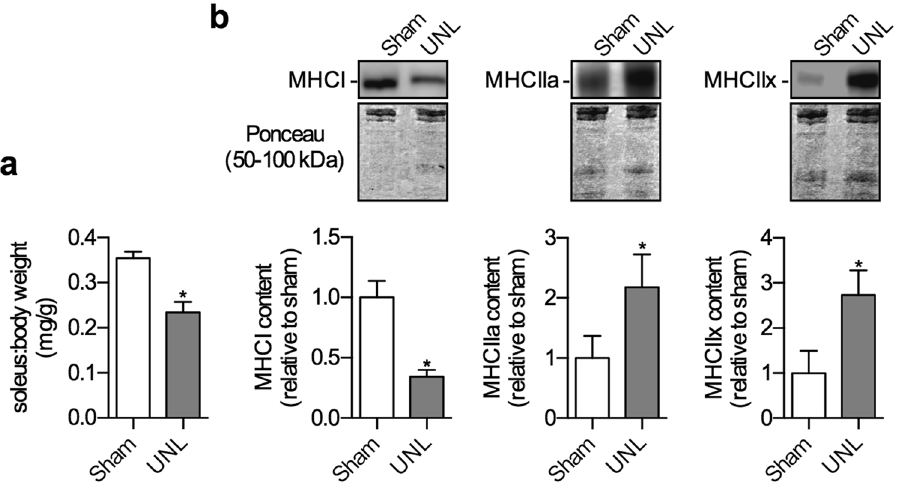
Figure 2. Changes in COXIV protein expression are indicative of changes in mitochondrial content. ( a ) COXIV protein is significantly higher in the overloaded (OVL) plantaris compared to sham. ( b ) COXIV protein is significantly lower in the unloaded (UNL) soleus compared to sham. * p ≤ 0.05 using a paired t-test (one- tailed), n = 6 per group. Please refer to Fig. S2 for full length Western blots.